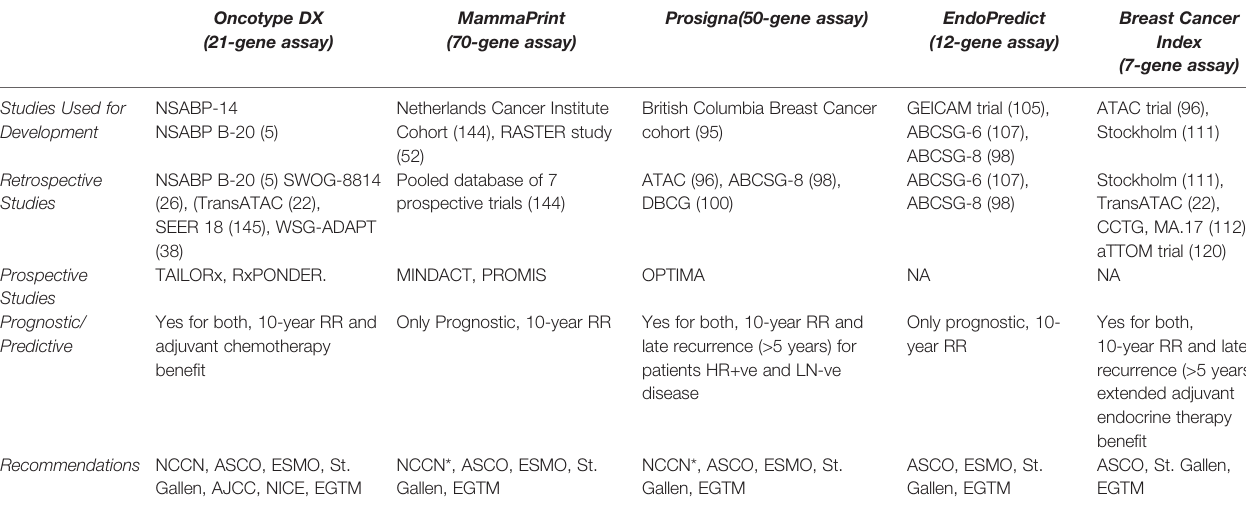
TABLE 2 | ASCO, American Society of Clinical Oncology; EGTM, European Group on Tumor Markers; ER+, Estrogen-receptor-positive; ESMO, European Society for Medical Oncology; NCCN, National Comprehensive Cancer Network; DBCG, Danish Breast Cancer Group; CCTG, Canadian Cancer Trials